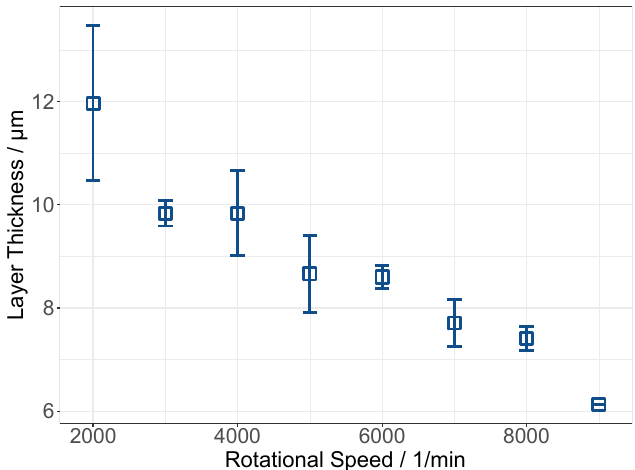
Figure 10. Layer height of CA dispersion on PES carriers at different coating speeds, with coating time of 1 min.